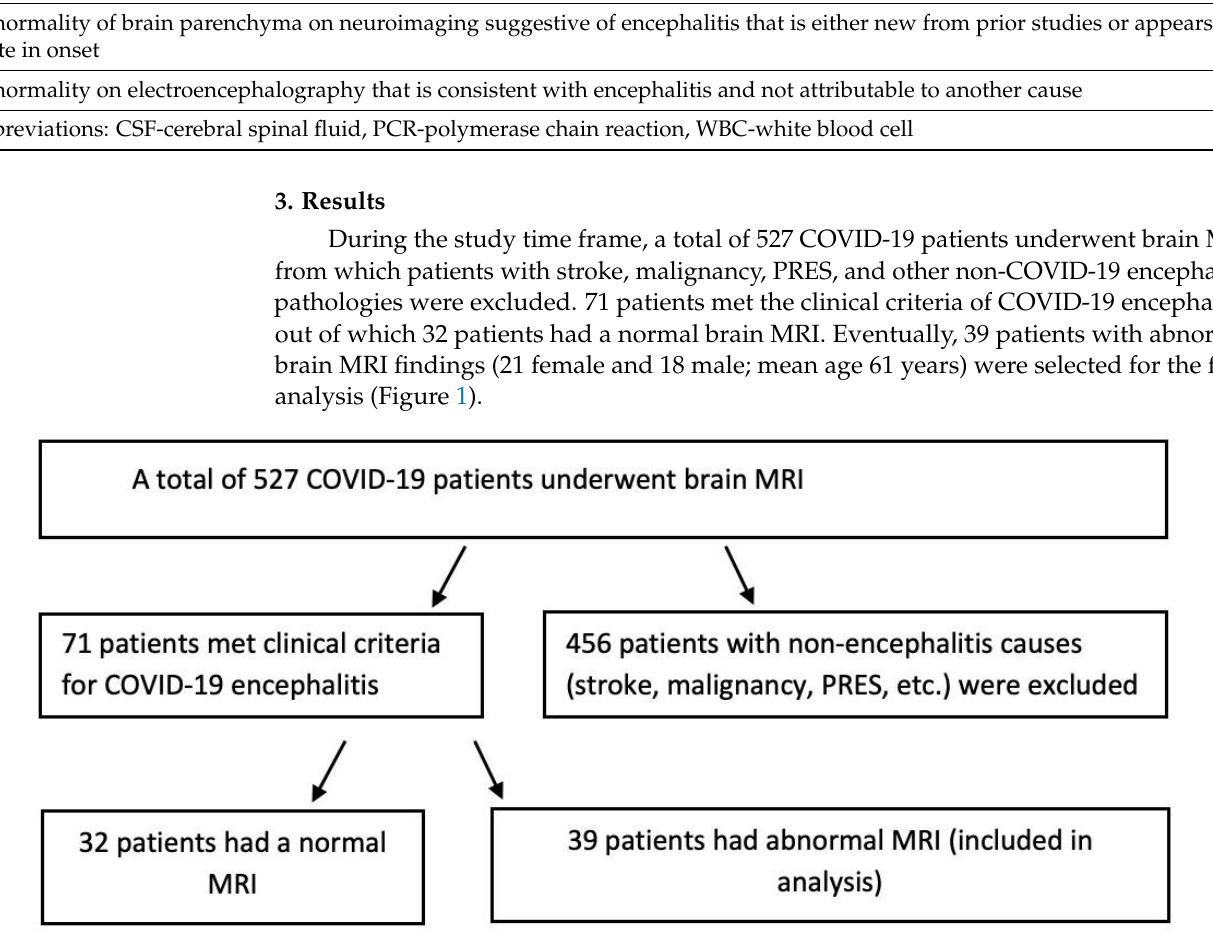
Table 1. Modified Diagnostic Criteria for COVID-19 Encephalitis [13].